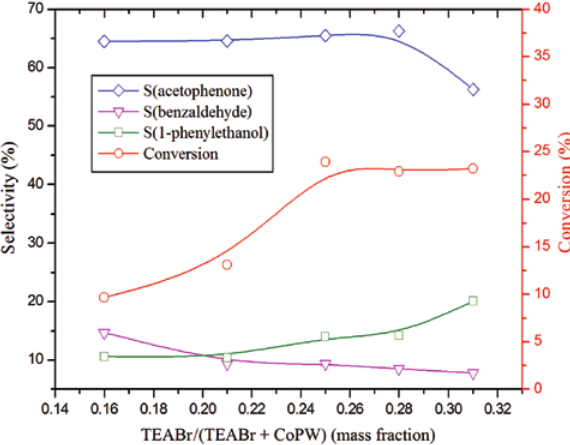
Figure 3: Effect of co-catalyst on the conversion and product selectivities over Co (H O /ethylbenzene) volume ratio = 2.5; T = 75 ° C; P(CO 2 2